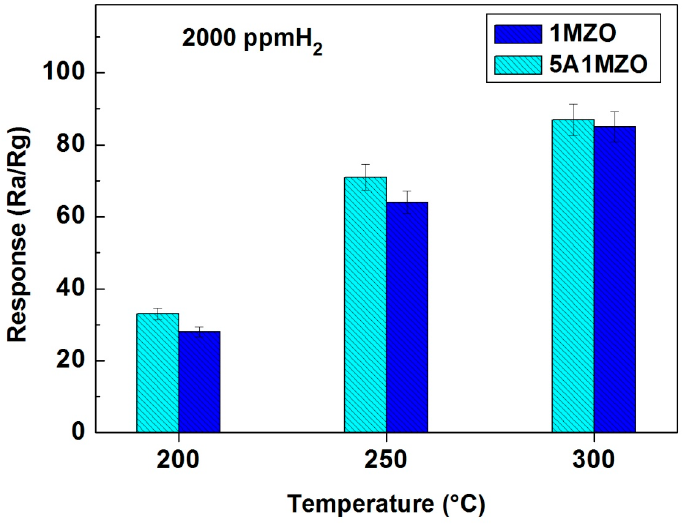
Figure 10. Responses of the 1MZO- and 5A1MZO-based sensors to 2000 ppm hydrogen versus operating temperatures.